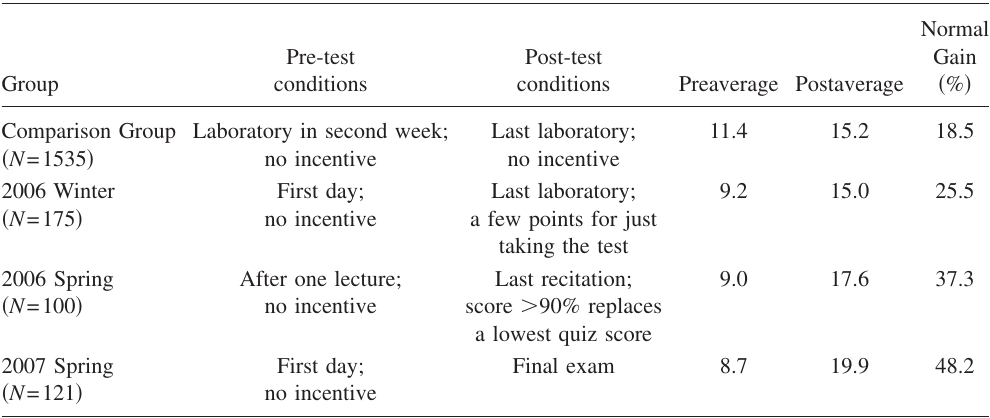
TABLE III. A summary of the test conditions and test results.